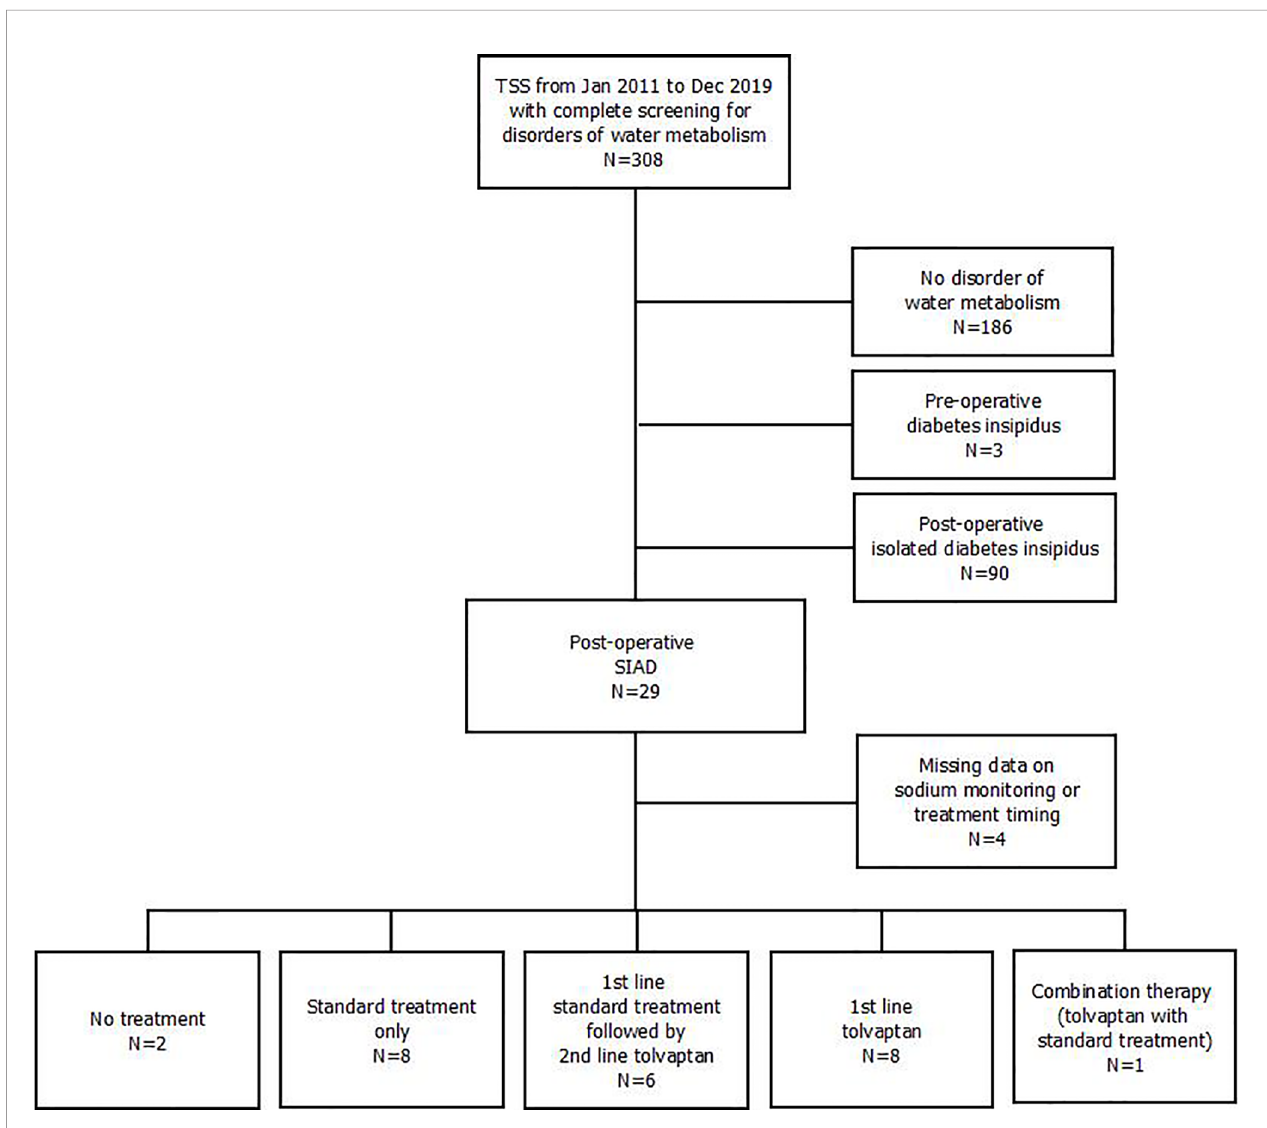
FIGURE 1 | Flow-chart outlining participants ’ selection. TSS, transsphenoidal sellar surgery; SIAD, syndrome of inappropriate